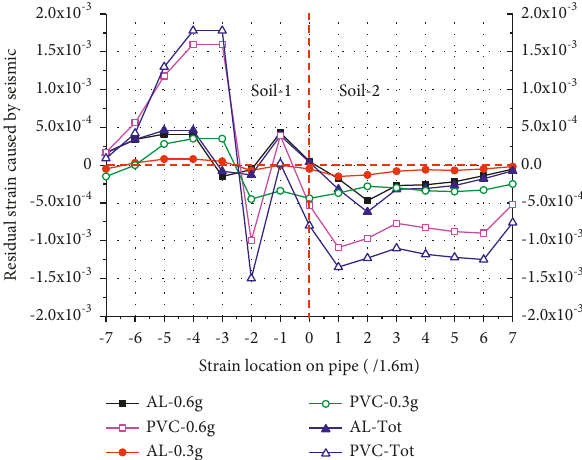
Figure 16: Residual strain of pipelines under different conditions.